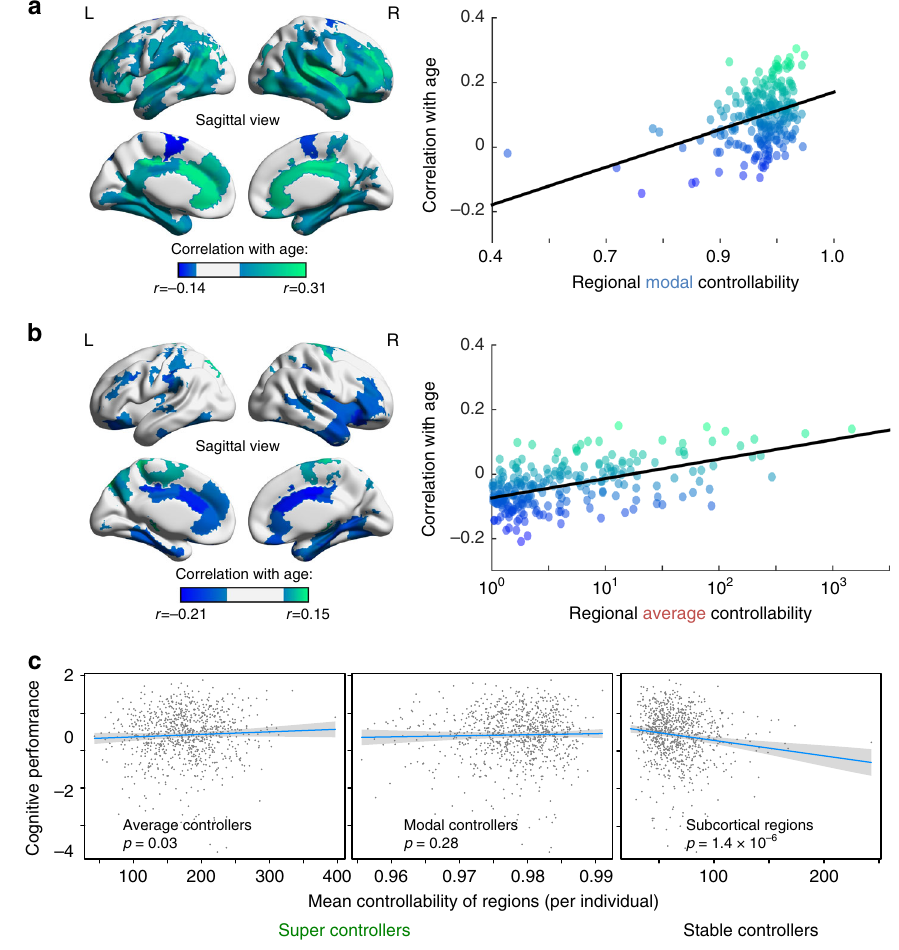
Fig. 3 Regional specialization with age and its impact on cognition. a (Left) Regions of signi fi cantly increasing modal controllability with age (green) and signi fi cantly decreasing modal controllability with age (dark blue). (Right) The green regions tend to be stronger modal controllers ( ‘ super-controllers ’ ), as seen by the positive slope between the age correlation and regional modal controllability values. b (Left) Regions of signi fi cantly increasing average controllability with age (green) and signi fi cantly decreasing average controllability with age (dark blue). (Right) The green regions tend to be stronger average controllers ( ‘ super-controllers ’ ), as seen by the positive slope between the age correlation and regional average controllability values. c (Left) Super average controllers (green regions that signi fi cantly increase in controllability with age and tend to have higher average controllability) show little relation with cognitive performance (age-normed). The blue line denotes the best linear fi t and the gray envelope denotes the 95% con fi dence interval. (Center) Super modal controllers also show little relation with cognitive performance. (Right) The regions that are most stable in controllability over development — subcortical regions — show a signi fi cant negative correlation between their average controllability and cognitive performance. These results suggest that the relative strength of controllers in subcortical vs. cortical regions is critical for understanding individual differences in overall cognitive function; i.e., a shift in control away from cortical regions may be detrimental to higher-order cognition. The fi ts in panel c all control for age, brain volume, head motion, sex, and